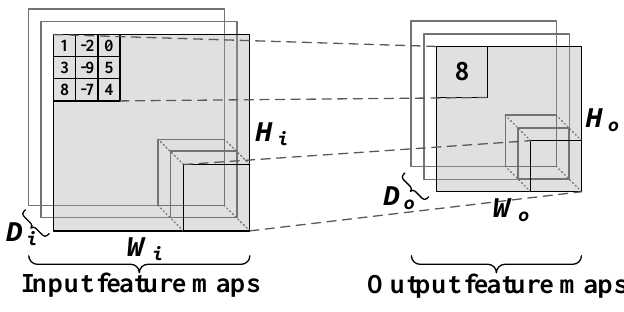
Figure 3. Pooling layer structure.